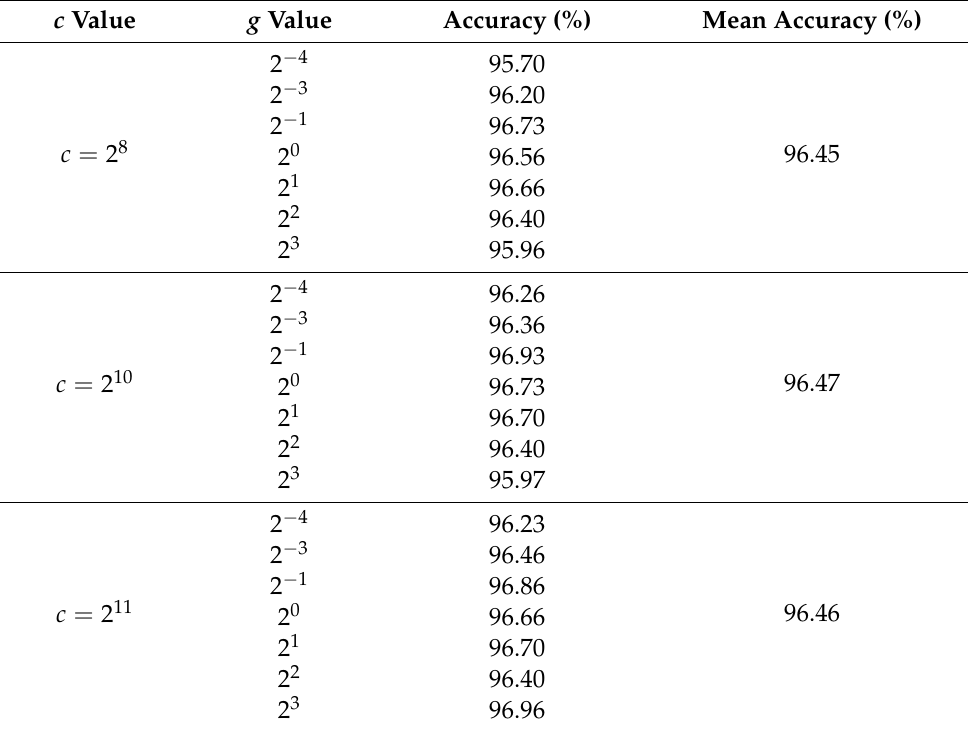
Table 4. The influence of g on accuracy (MIT-BIH arrhythmia